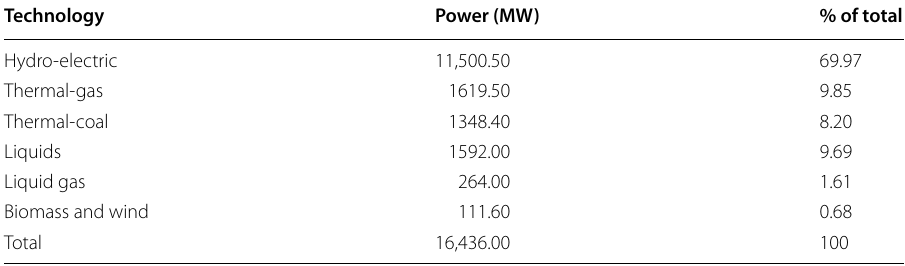
Table 1 Installed capacity by technology. Reproduced with permission from UPME (2015)